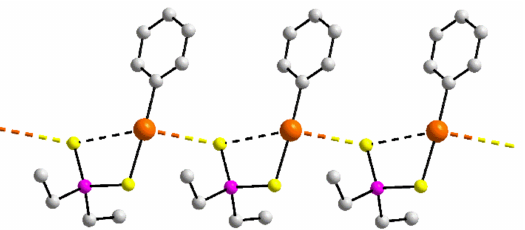
Figure 12. Supramolecular association in a one-dimensional aggregate featuring Hg ··· S interac- tions: 38